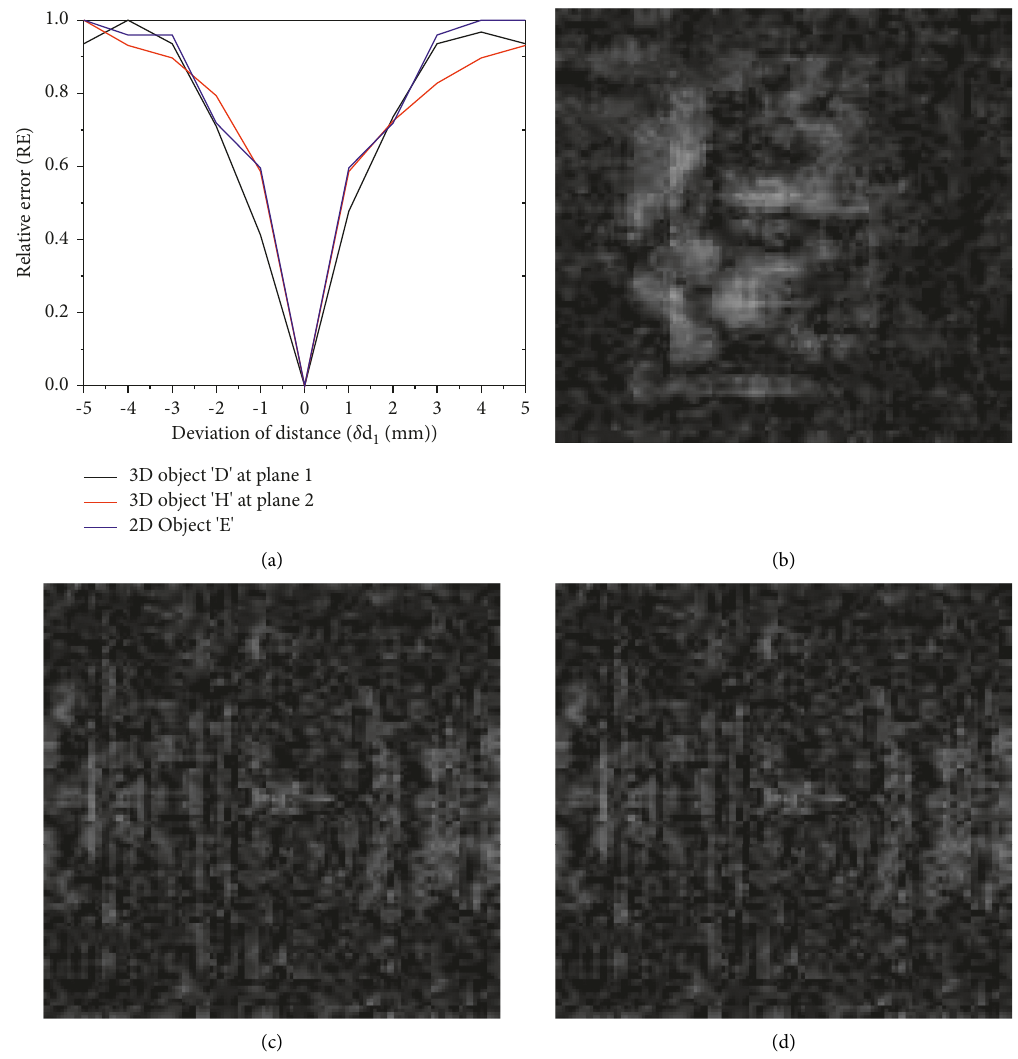
Figure 12: Decrypted results with incorrect d distances: (a) the RE plot corresponding to the deviation of distance; (b) reconstructed 2D object with 1 � 41mm; (c), (d) reconstructed 3D object wave with wrong distance d wrong distance d 1